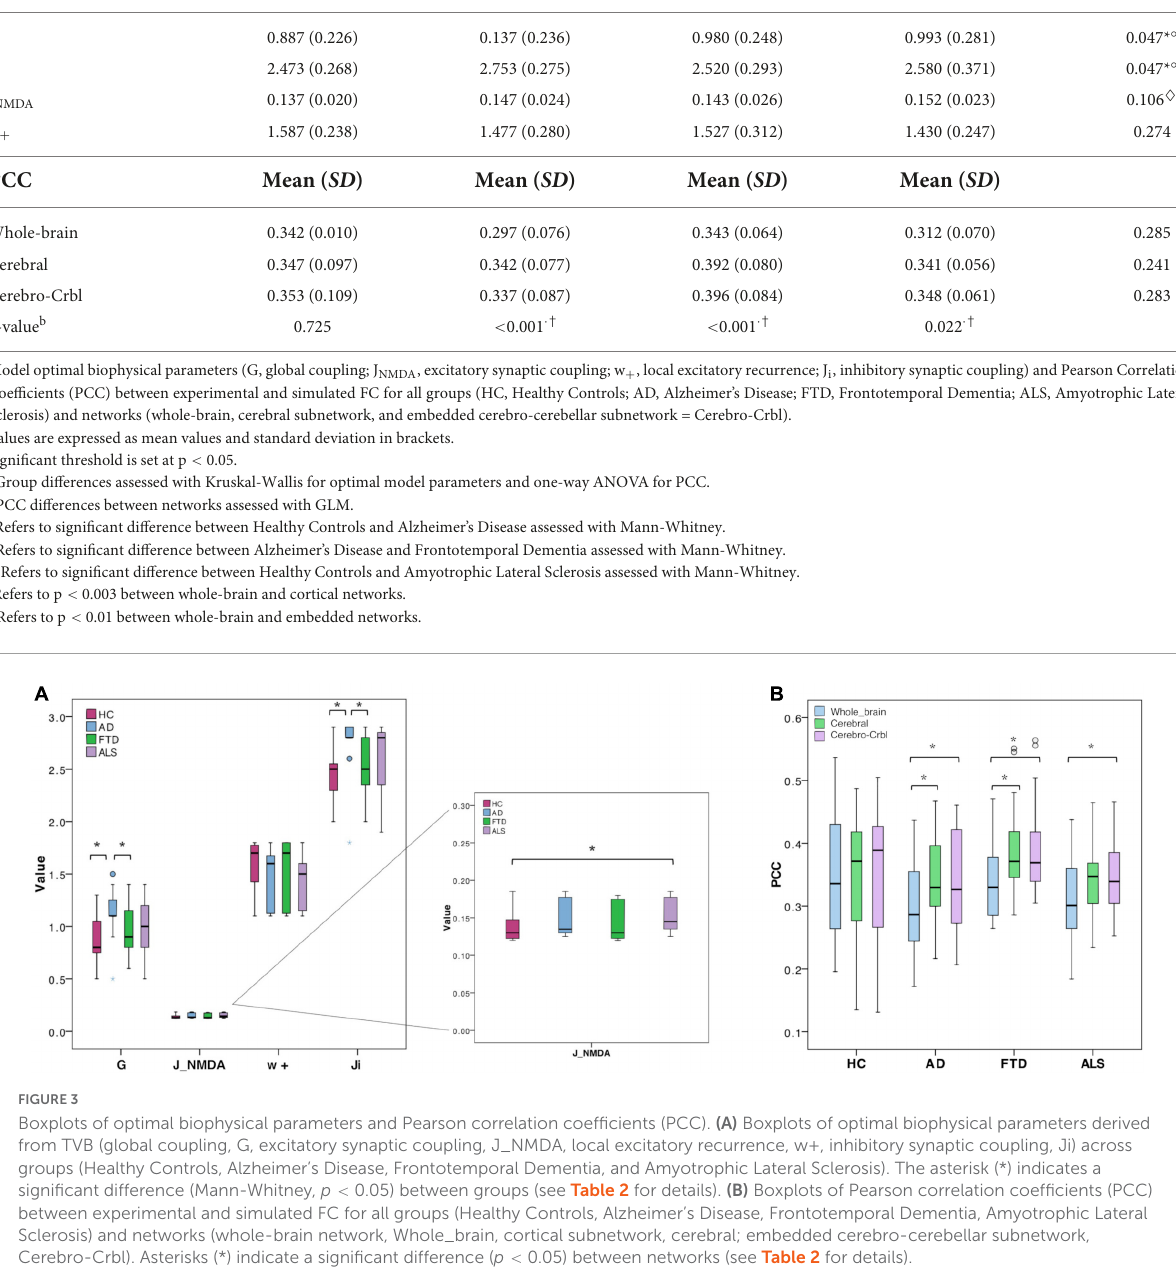
(33.3%) and hardly present in Amyotrophic Lateral Sclerosis (6.7%) and Alzheimer’s Disease subjects (0%); cluster 4 was the most frequent in Alzheimer’s Disease (60%) and